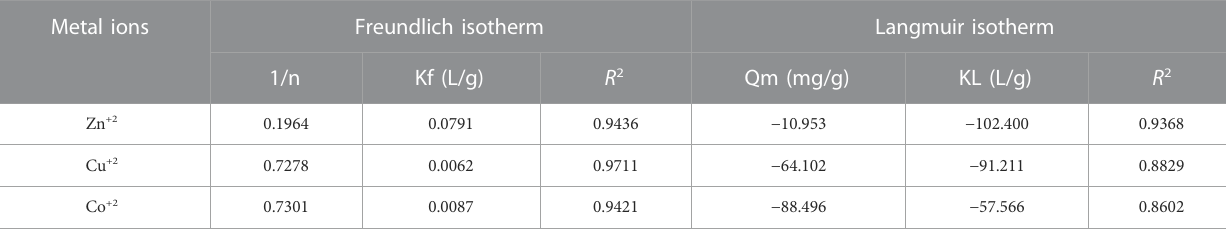
TABLE 2 Parameters for Freundlich and Langmuir isotherms (soil samples).